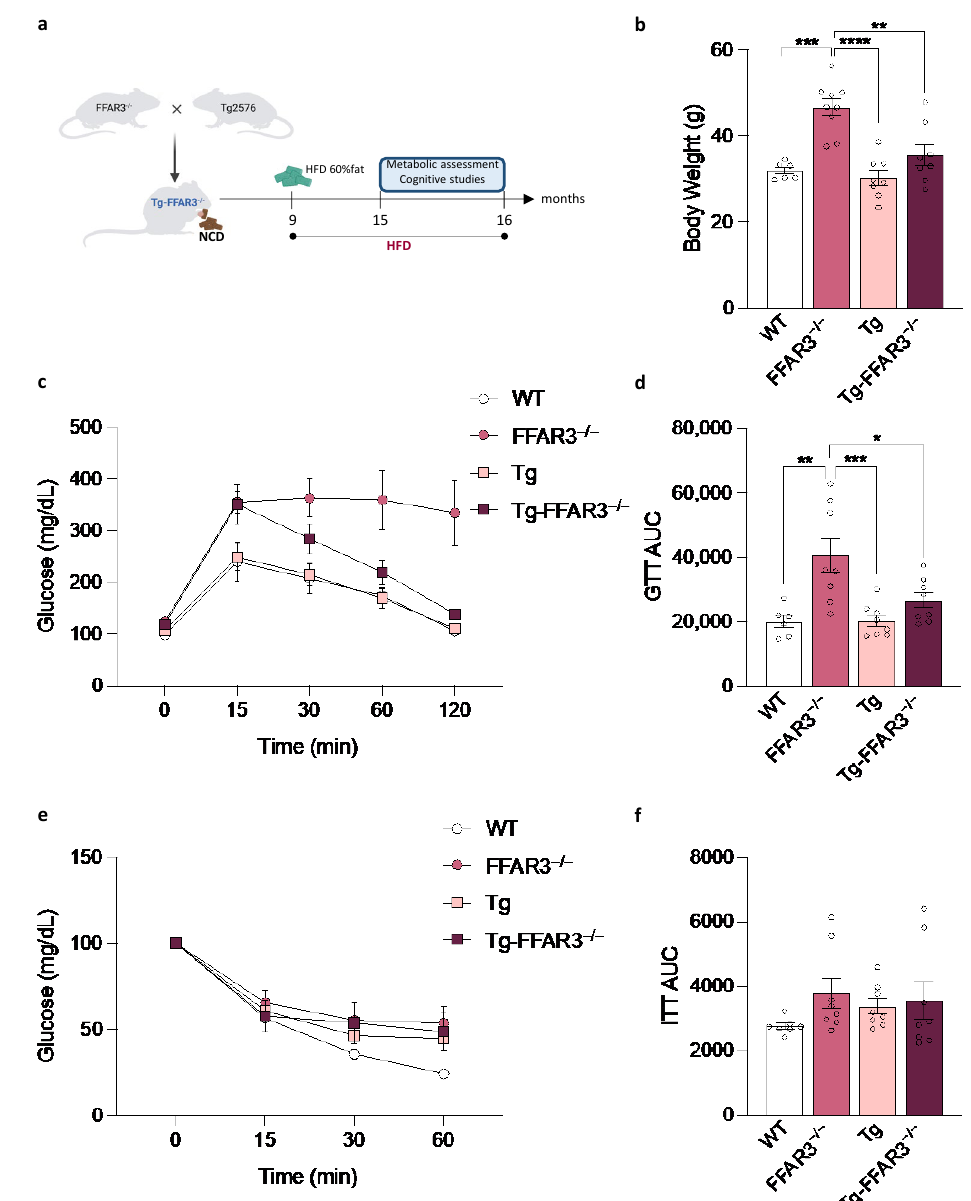
Figure 2. FFAR3 ablation-induced body weight elevation and glucose intolerance is not present in Tg2576 mice fed with high-fat diet (HFD). ( a ) Schematic representation of the strategy used to generate Tg2576 mice lacking FFAR3, dietary intervention with HFD (starting at 9 months of age), and the subsequent metabolic assessment (at 15 months of age). ( b ) Body weight evaluation of wild type (WT), FFAR3 knockout (FFAR3 −/− ), Tg2576 (Tg) and Tg2576 FFAR3 knockout mice (Tg-FFAR3 −/− ) subjected to HFD. ( c ) Glucose tolerance test (GTT) and ( d ) the corresponding AUC quantification of mice subjected to HFD. ( e ) Insulin tolerance test (ITT) and ( f ) the corresponding AUC quantification of mice fed on HFD. Results are expressed as mean ± SEM and circles in the subfigures represent each individual value ( n = 6–8 in each group). * p < 0.05, ** p < 0.01, *** p < 0.001, two-way ANOVA followed by Tukey.